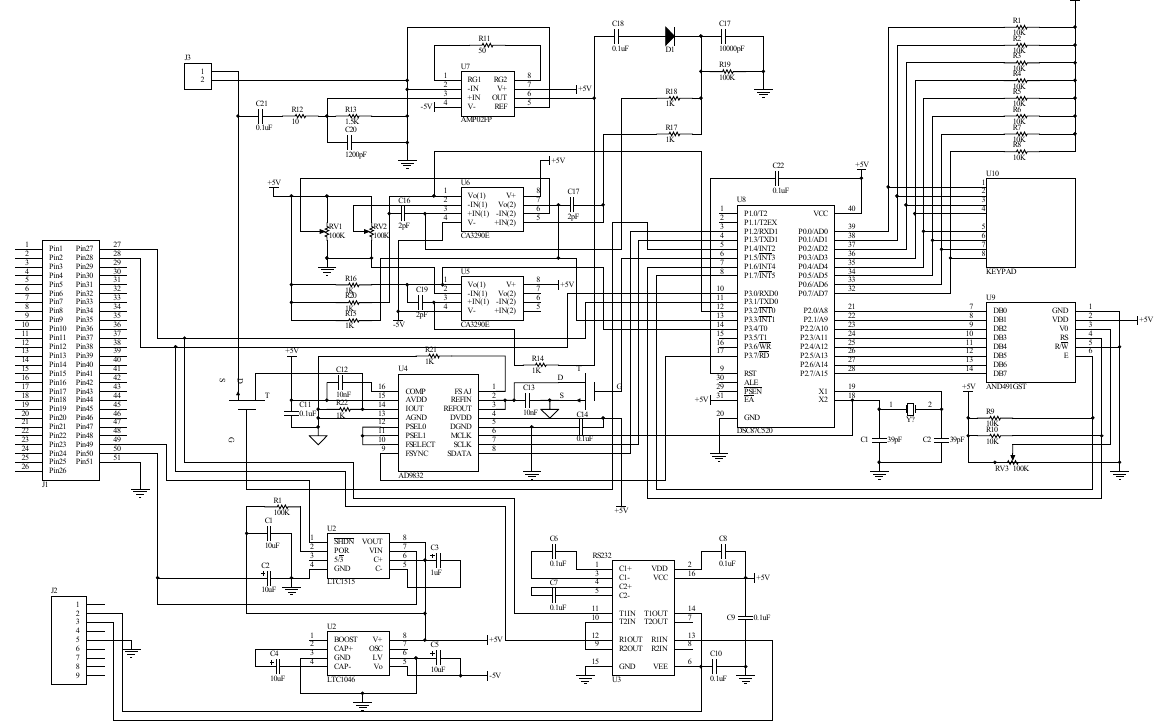
Figure 10. The circuit schematic of the sensor interface module. The circuit is connected to the magnetoelastic sensor detection solenoid via Connector J3 at the top left corner. The circuit can be interfaced to the sensor node via Connector J1, or directly to a computer via Connector